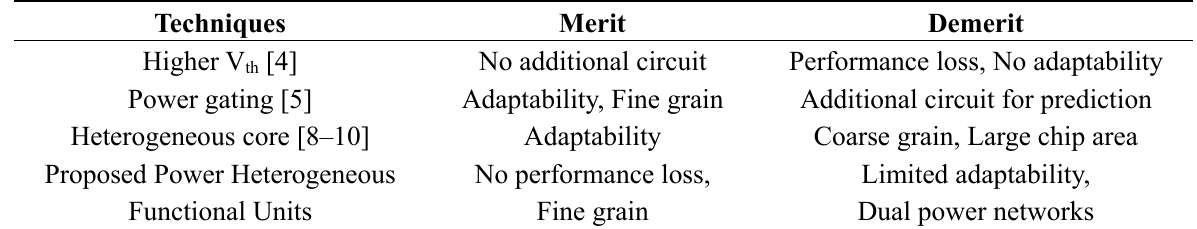
Table 3. Comparison of low-power